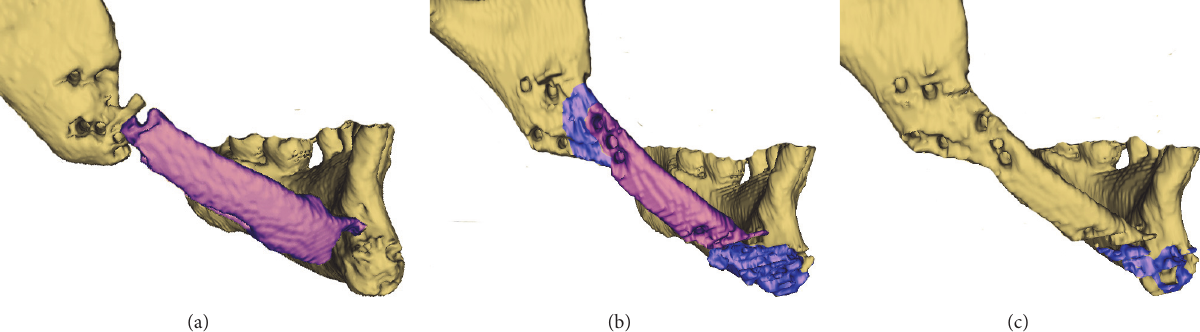
Figure 5: The patient’s mandible in different time points after bone grafting with the gene-activated bone substitute: (a) before; (b) 6 months; (c) 12 months. Dental CT; 3D reconstruction with volume rendering 250–2000 HU (titanium constructs are excluded).